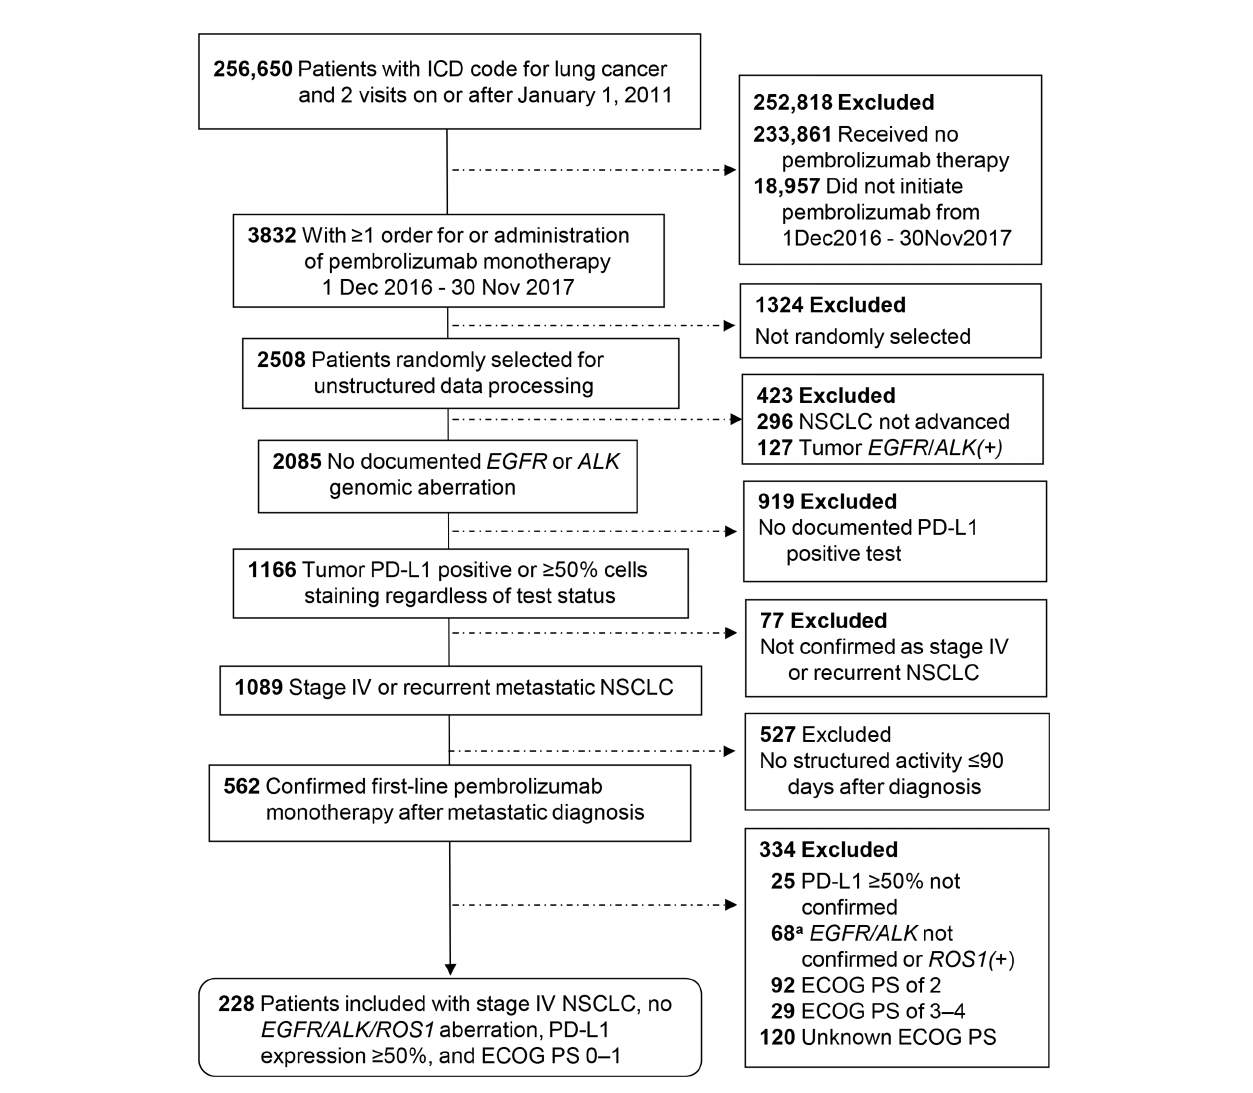
FIGURE 2 | Patient selection for the spotlight cohort from the Flatiron Health Database. a Exclusion for lacking con fi rmation of negative test status for EGFR/ALK genomic aberration applied only to nonsquamous tumors. ECOG PS, Eastern Cooperative Oncology Group performance status; PD-L1, programmed cell death-ligand